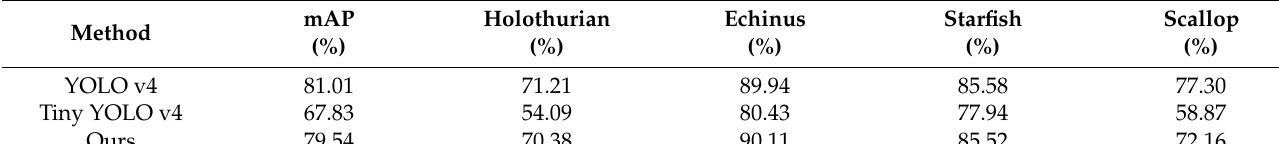
Table 8. Detection results of the proposed method on the URPC 2020 dataset.